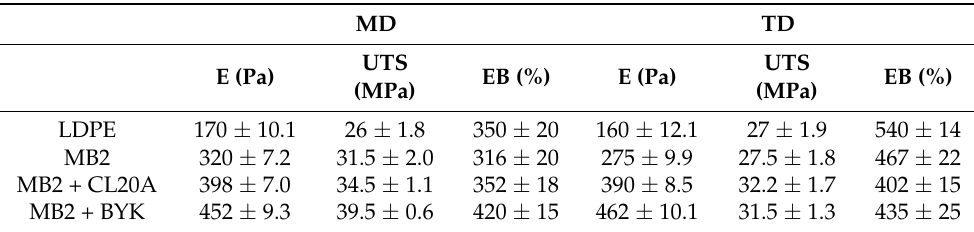
Table 3. Main tensile properties in machine direction (MD) and transverse direction (TD) of LDPE, unfilled MB2 and MB2-based bionanocomposite blown